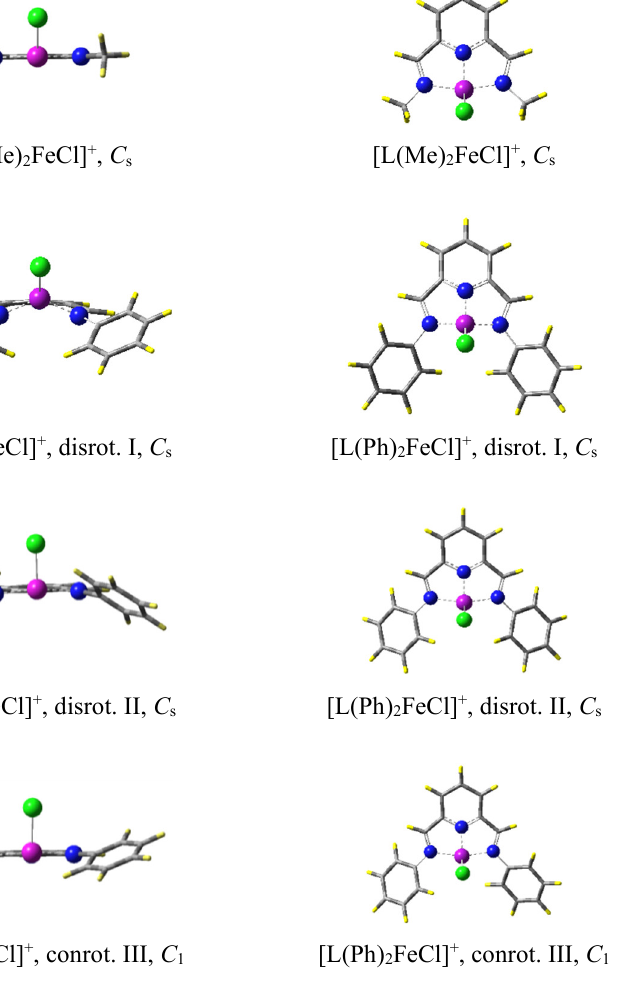
Figure 2. Iron dichloride pre-catalysts L(R) 2 FeCl 2 are shown in the column on the left and two per- spectives of the iron monochloride pre-catalysts [L(R) 2 FeCl] + are shown in the other two columns. perspectives of the iron monochloride pre-catalysts [L(R)